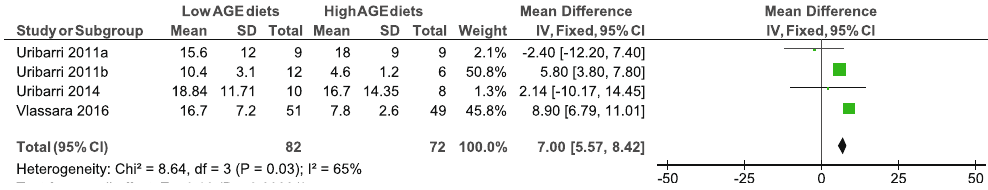
Figure 5. Meta-analysis of low AGE and high AGE diets for adiponectin ( µ g/ml): forest plot shows the effect of low AGE and high AGE diets on